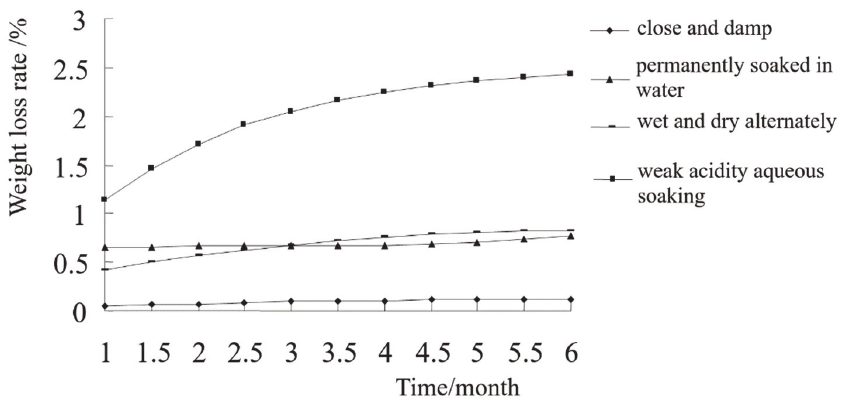
Figure 1: Distribution of anchor steel weight loss rate with